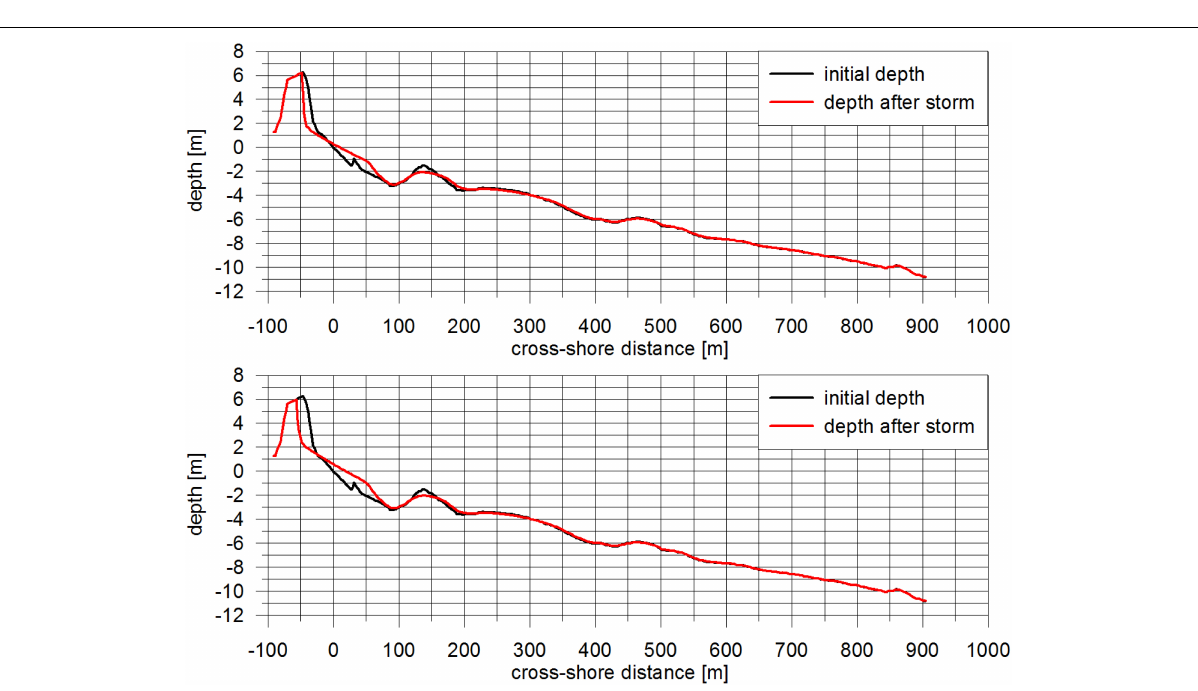
FIGURE 8 | Results of simulation of storm effect for Bukowo barrier, km 285: surge 1.3 m (top) , 2 m (bottom) .